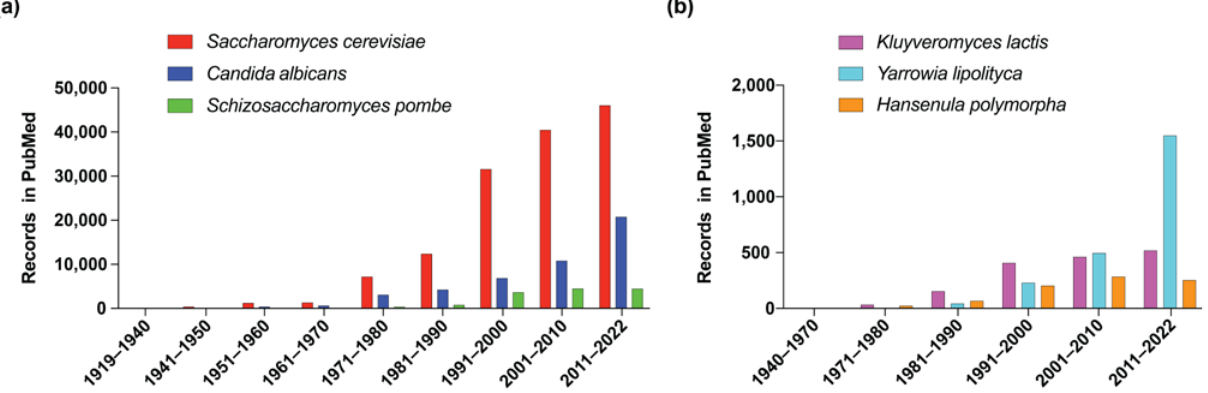
Figure 1. Evolution of yeast publications in PUBMed. ( a ) Conventional and ( b ) less-conventional